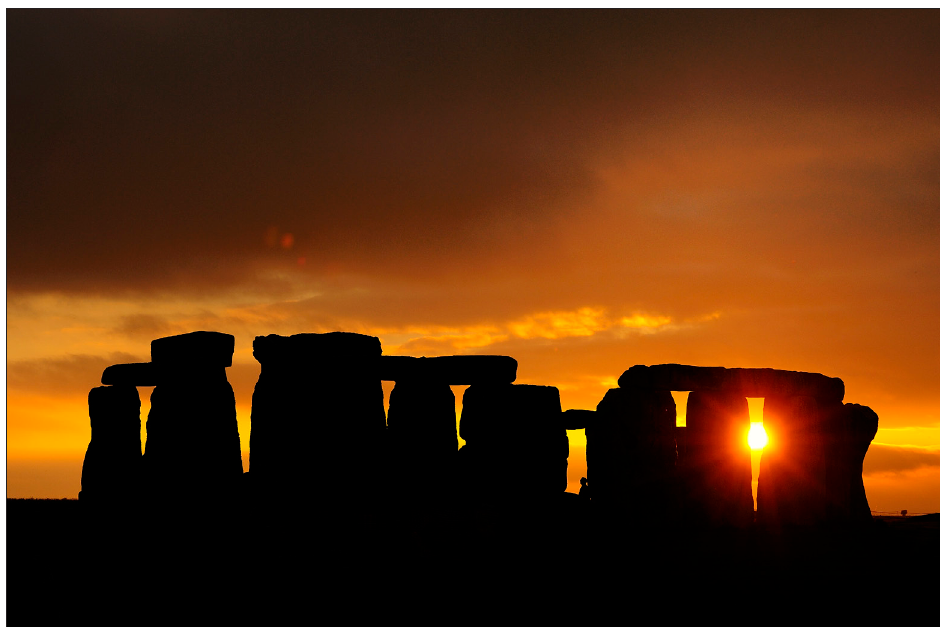
Figure 6: Sunset at Stonehenge (Photo Adam Stanford, Aerial-Cam